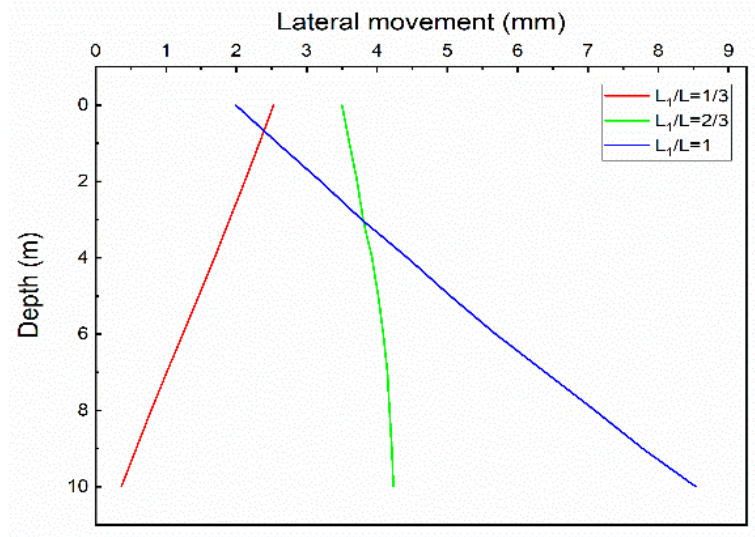
Figure 8. Simulated distribution of vertical soil movement adjacent to friction pile.